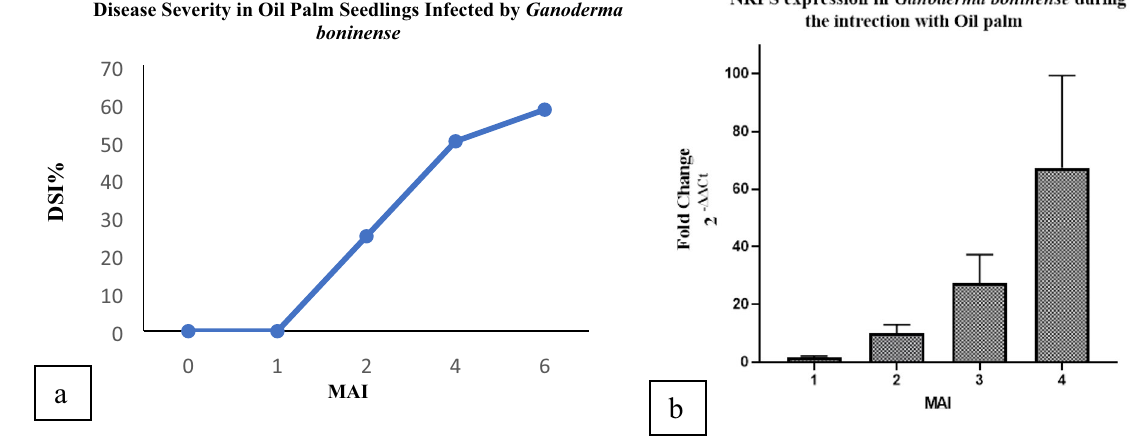
Figure 6. ( a ) Assessment of Disease Severity Index (DSI) of oil palm seedlings challenged with Ganoderma boninense at monthly intervals 0, 1, 2, 4, 6 after inoculation based on external disease symptoms and rated based on 0–4 disease severity value 1 . ( b ) Relative quantification of NRPS transcript as fold change (2 -ΔΔct ) during G. boninense -oil palm interaction. Bars represent the average mean ± SEM of three technical replicates from three biological replicates. MAI month after pathogen